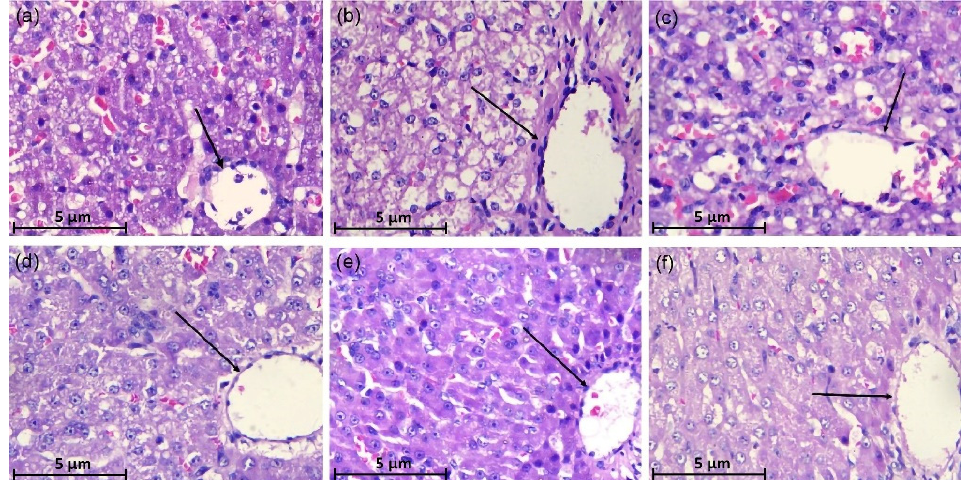
Figure 2. Histopathology of Acute Liver Injury in dogs. control ( a ), CCl 4 ( b ), BDDP ( c ), PCPE ‐ H ( d ), PCPE ‐ M ( e ) and PCPE ‐ L ( f ) treatments (HE, 400×). The arrows indicate the canine liver portal area in the figure.